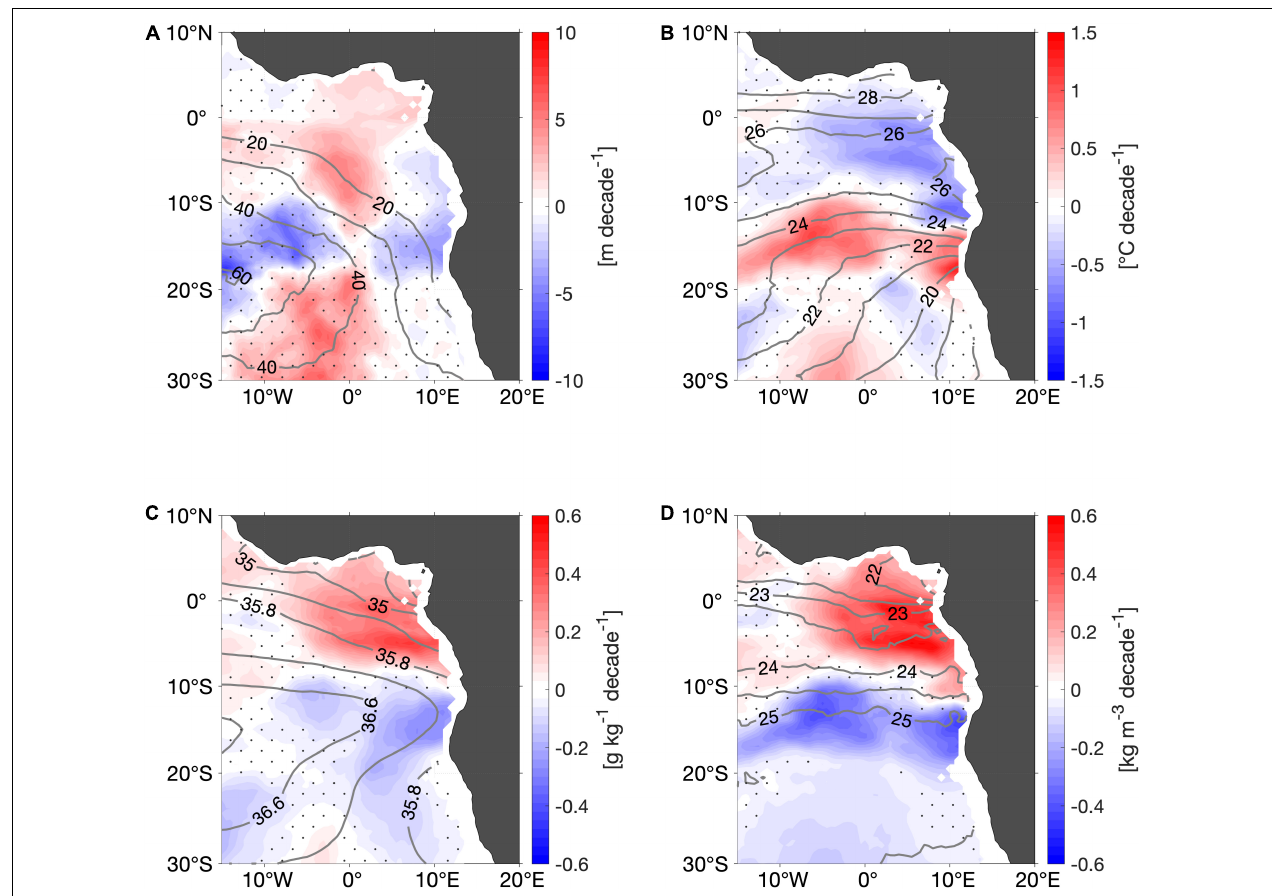
FIGURE 5 | Decadal trend of (A) mixed layer depth (MLD), (B) mixed layer temperature (MLT), (C) mixed layer salinity (MLS), and (D) mixed layer potential density anomalies from Argo for the time period of 2006–2019. Trends are computed from the anomalies relative to the seasonal mean. Mixed layer properties have been estimated with the Holte and Talley algorithm (Holte and Talley, 2009). Gray contour lines show the mean fields for the period of 2006–2019, respectively. Areas where the trend is not of 95% significance are stippled. Please note, positive trend of MLD refers to a deepening of the mixed layer. Shelf regions below 2,000 dbar are blanked